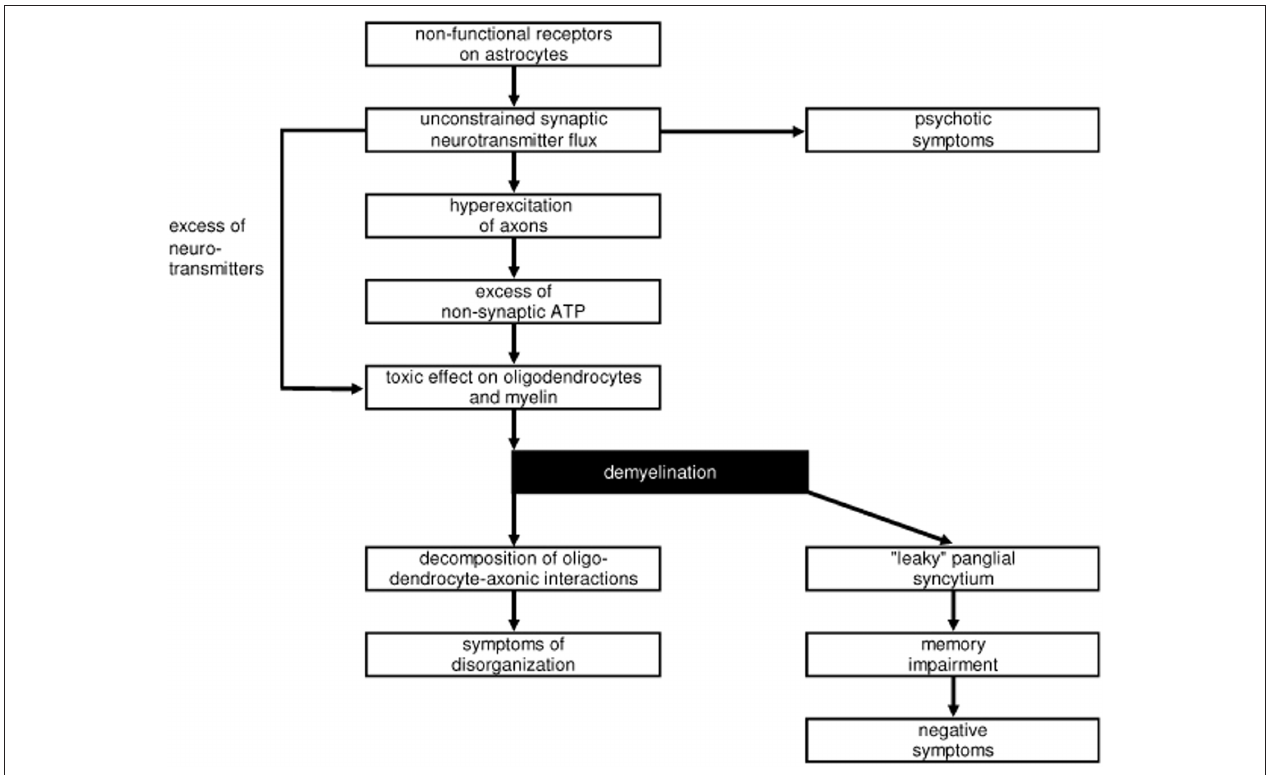
Figure 11 | Schematic diagram of impaired glial-neuronal interactions that may be responsible for the main symptoms of schizphrenia (see text).